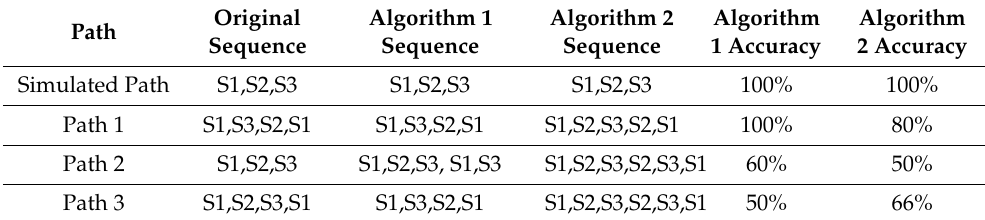
Table 3. Comparison of algorithms’ estimated